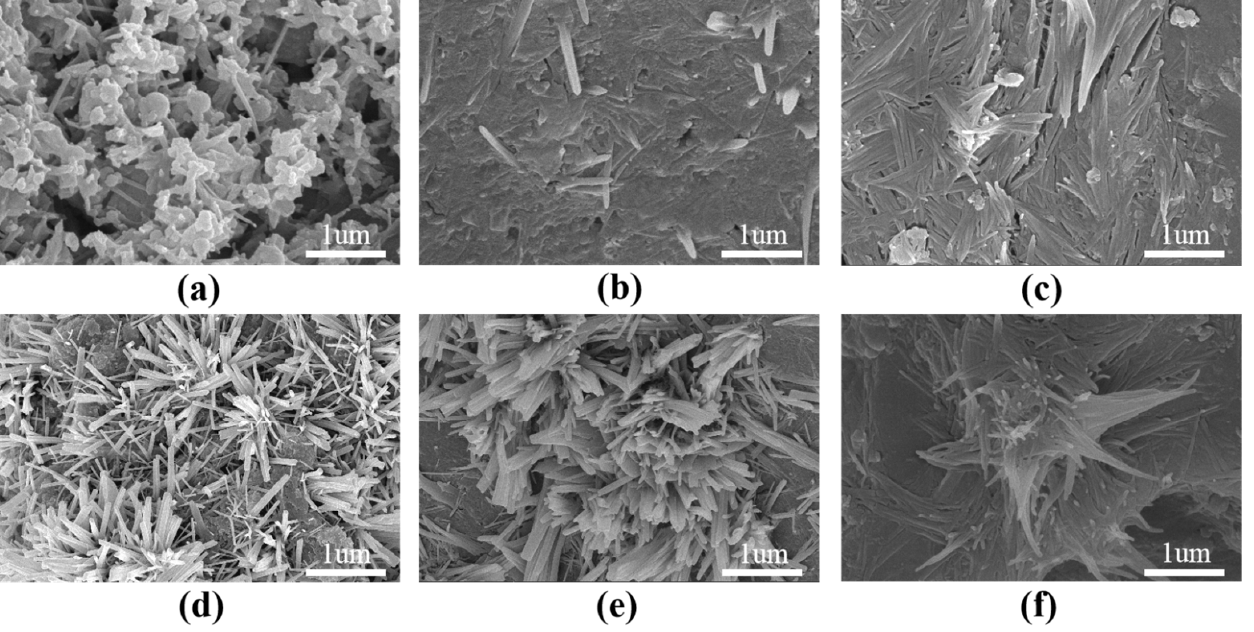
Figure 9. SEM images of the HSLWC with varying GO content at 28 days: ( a ) 0.00%; ( b ) 0.02%; ( c ) 0.04%; ( d ) 0.05%; ( e ) 0.06%; ( f )